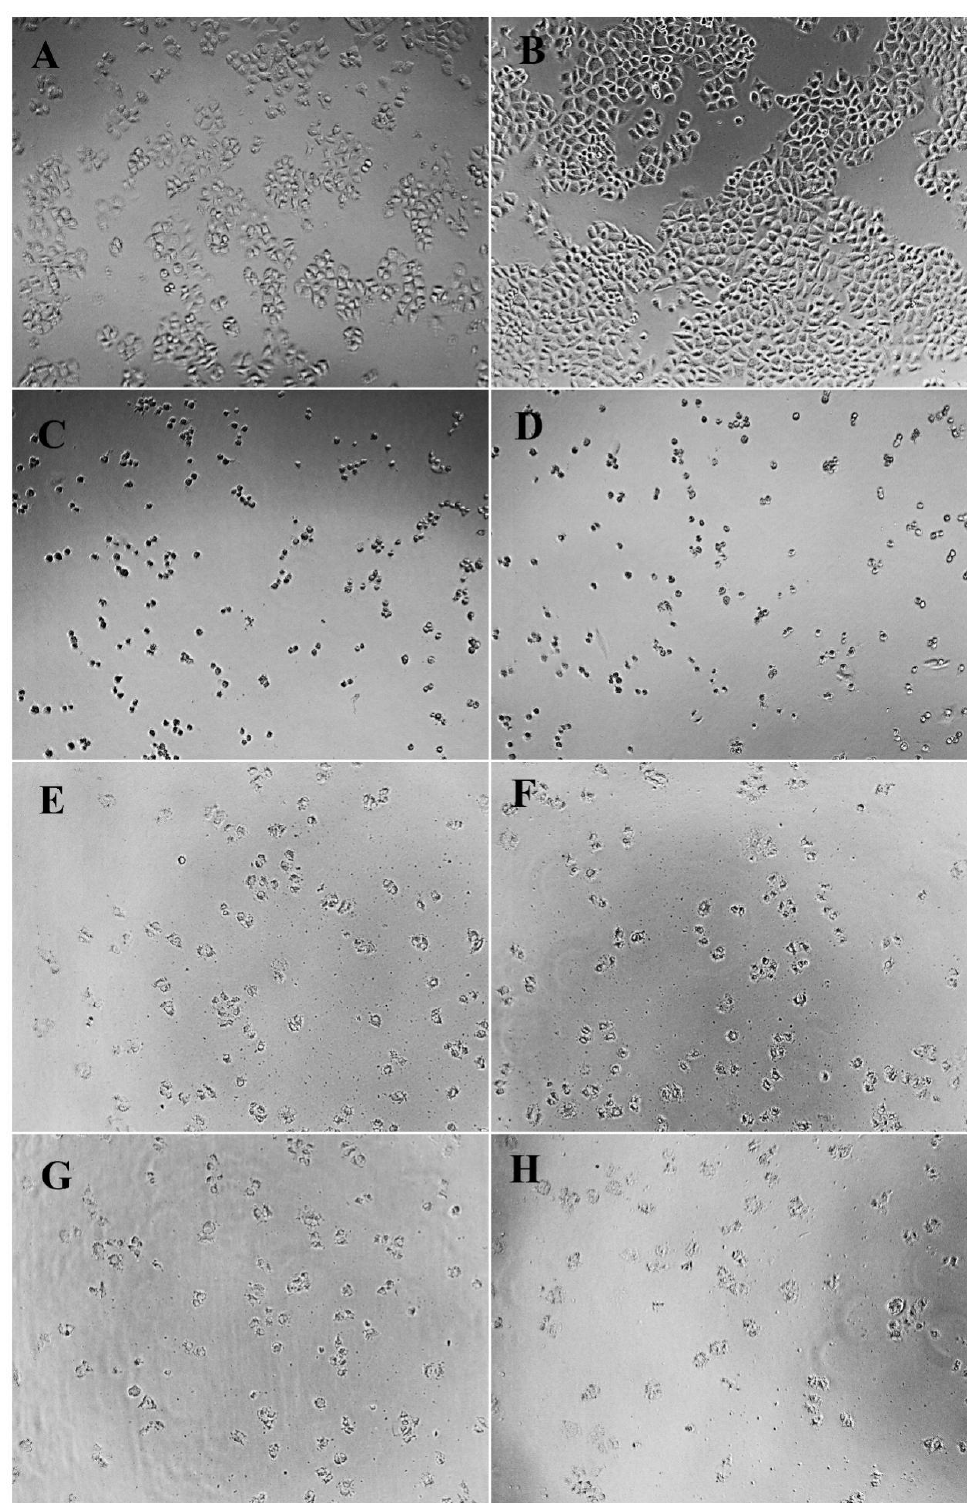
Figure 5. Effect of PPCFCTL on morphology of HepG2 cells. Negative control group (( A ) 24 and ( B ) 48 h), 150 µg/mL 5-FU treatment group (( C ) 24 and ( D ) 48 h), 750 µg/mL PPCFCTL treatment group